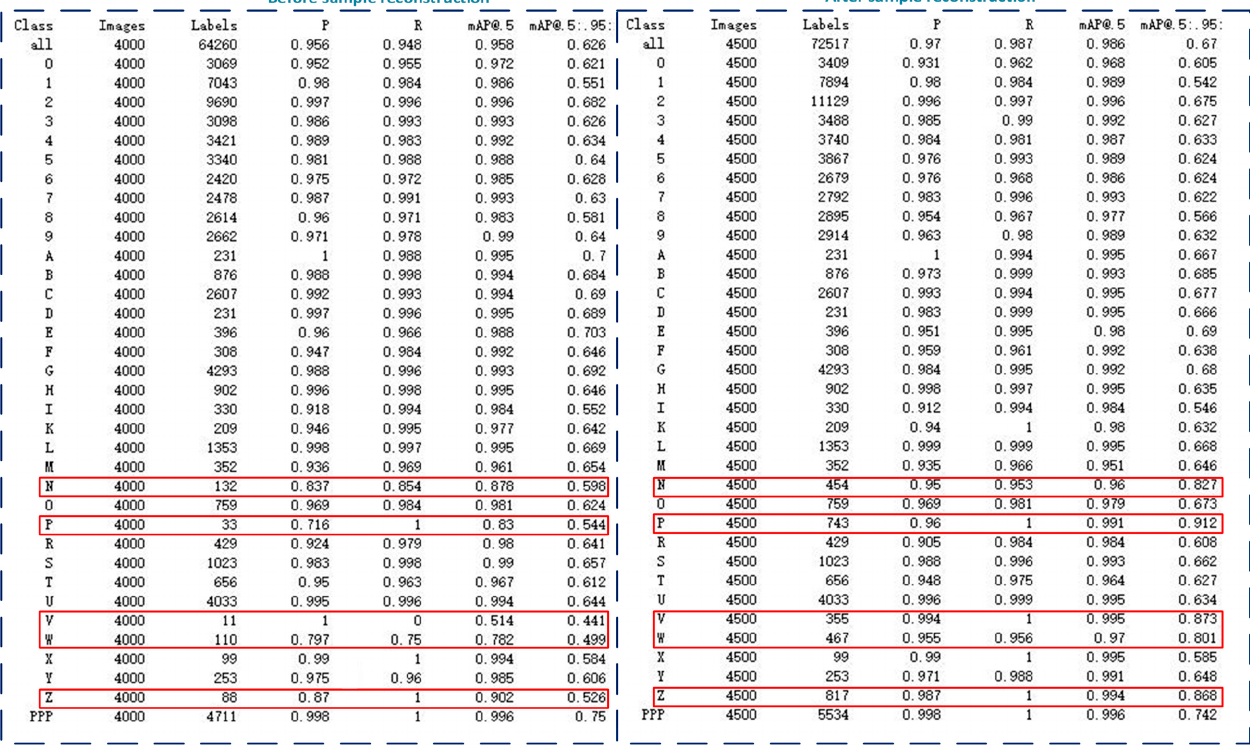
Figure A3. Comparison of category detection results after amplification of small sample characters.